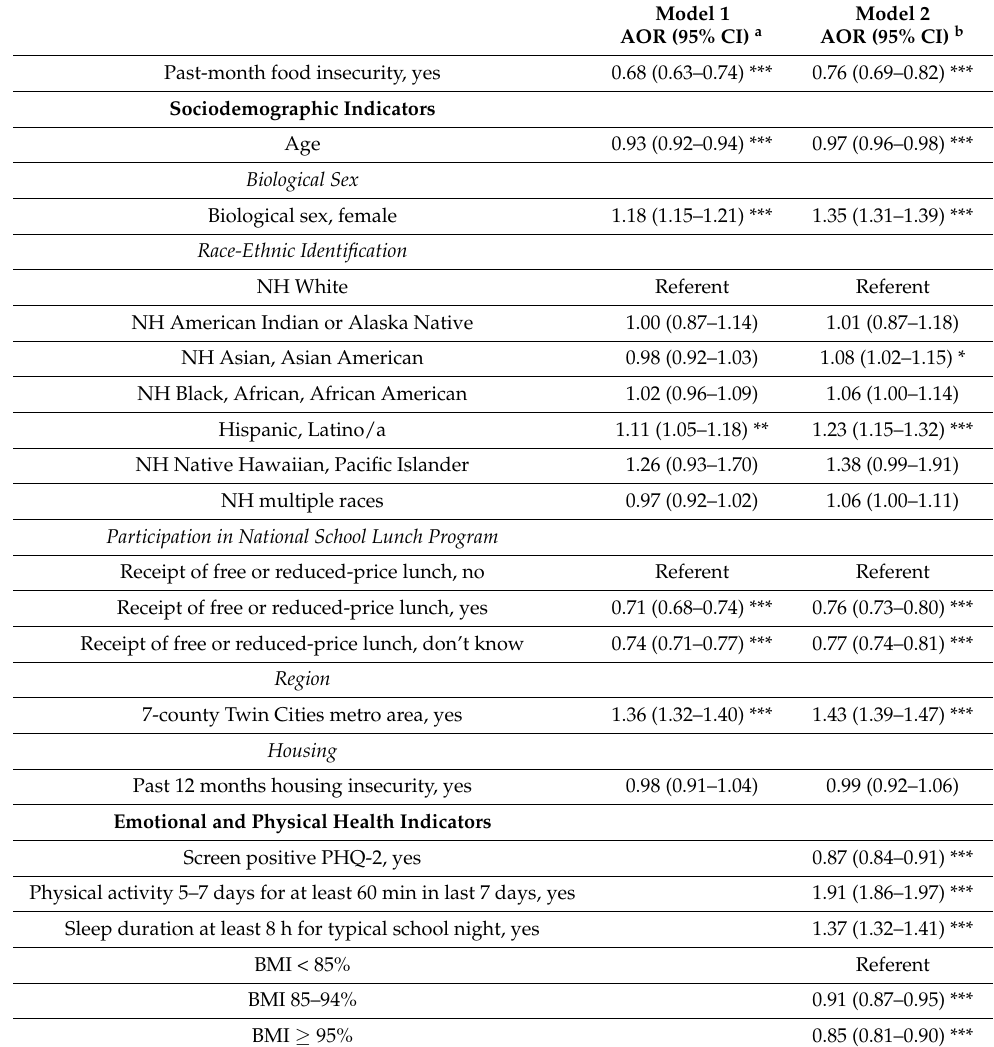
Table 2. Past-Month Food Insecurity and Student Consumption of Fruit Two or More Times/Day, Past 7